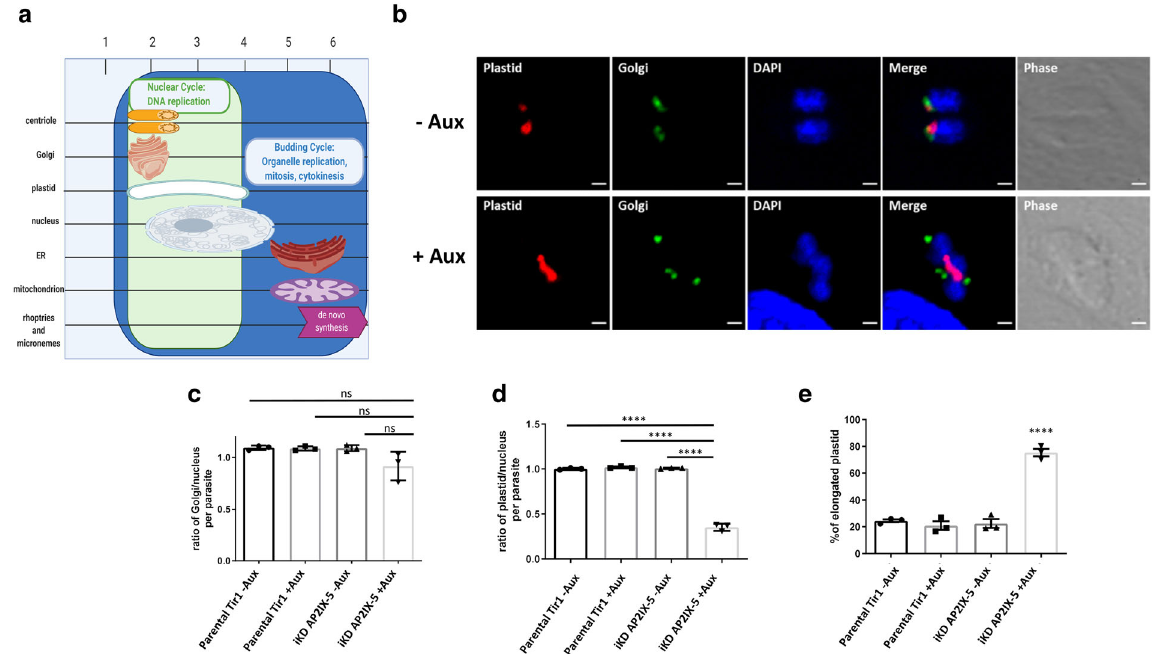
Fig. 4 Organelle replication in iKD TgAP2IX-5 throughout the tachyzoite asexual cell cycle. a Schematic representation of the chronological order of organellar division throughout a normal Toxoplasma gondii cell cycle. Nuclear cycle is indicated in green and budding cycle is indicated in blue. Timeframe of each organelle division is represented by length of representative organelle. b Confocal microscopy of iKD TgAP2IX-5 parasite with labelled plastid (red) and Golgi (green) in the presence and absence of overnight auxin treatment. The lower panel clearly represents the elongated plastid phenotype. DAPI was used to stain the nucleus. Scale bar is indicated at the lower right side of each image. c Bar graph representing the ratio of Golgi: nucleus using the parental and iKD TgAP2IX-5 strains in the absence and presence of overnight auxin treatment. A Student ’ s t -test was performed, two-tailes p -values: p = 0.0948 (iKD TgAP2IX-5 + auxin compared to Parental Tir1 − auxin), p = 0.1039 (iKD TgAP2IX-5 + auxin compared to Parental Tir1 + auxin), p = 0.1030 (iKD TgAP2IX-5 + auxin compared to iKD TgAP2IX-5 − auxin); mean ± s.d. ( n = 3 independent experiments). d Bar graph representing the ratio of plastid to nucleus using the parental and iKD TgAP2IX-5 strains in the absence and presence of overnight auxin treatment. A Student ’ s t -test was performed, two- tailed p -values: **** P < 0.0001; mean ± s.d. ( n = 3 independent experiments). e Bar graph representing the percentage of parental and iKD TgAP2IX-5 parasites with an elongated plastid in the absence and presence of overnight auxin treatment. A Student ’ s t -test was performed, two-tailed p -values: **** P < 0.0001; mean ± s.d. ( n = 3 independent